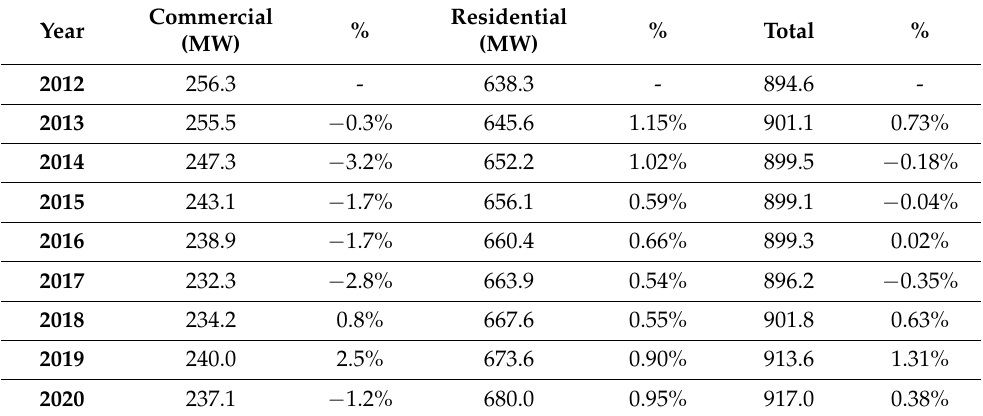
Table 1. Total installed capacity for residential and commercial consumers connected to DHS in the period from 2012 to